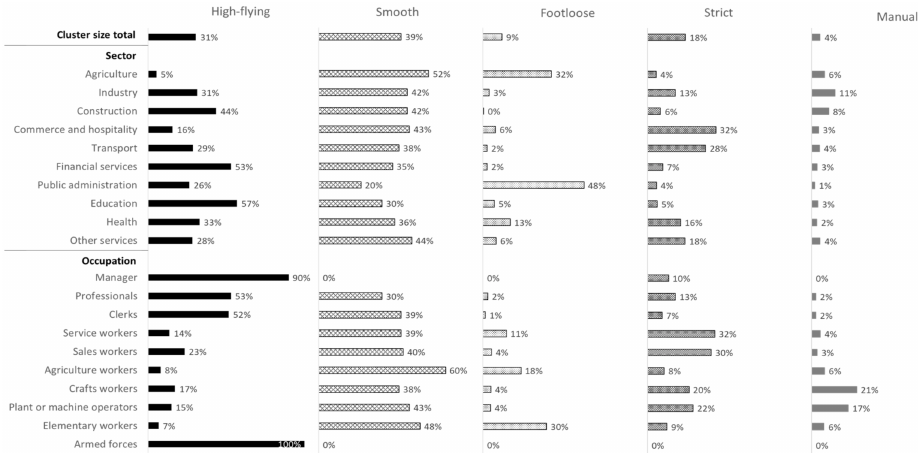
Figure 4. Job quality profiles by sector and occupation (% of employees in each category).